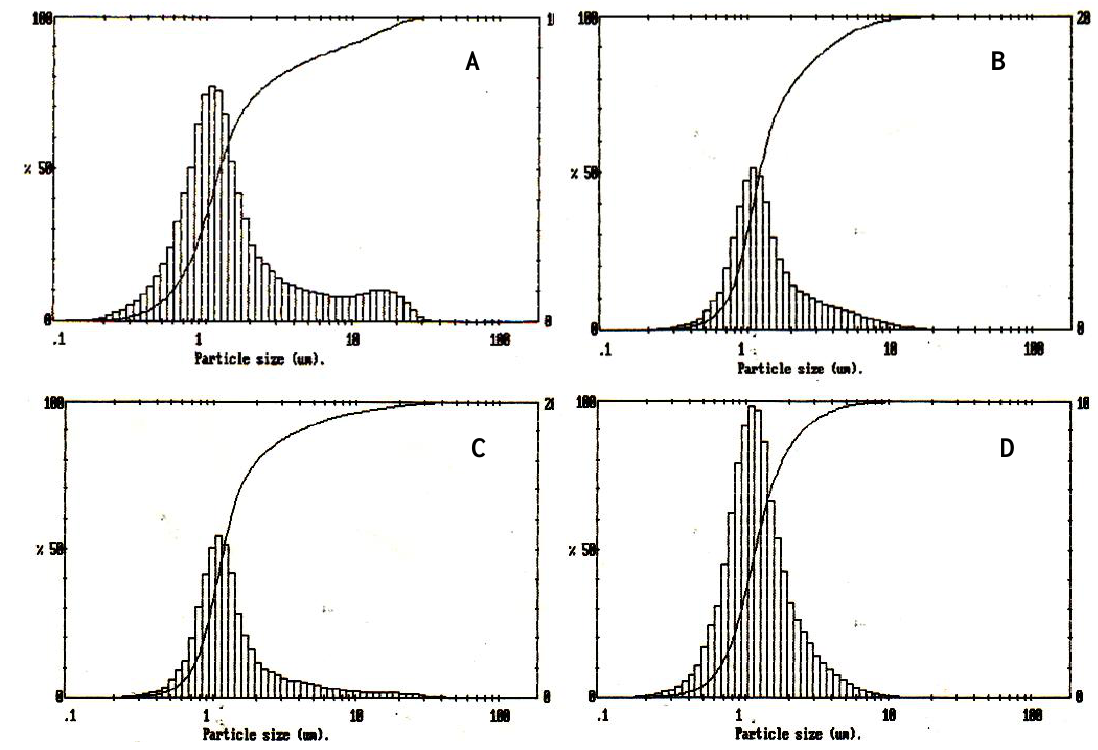
Figure 1. Size distribution analysis of P(3HB) microspheres prepared using